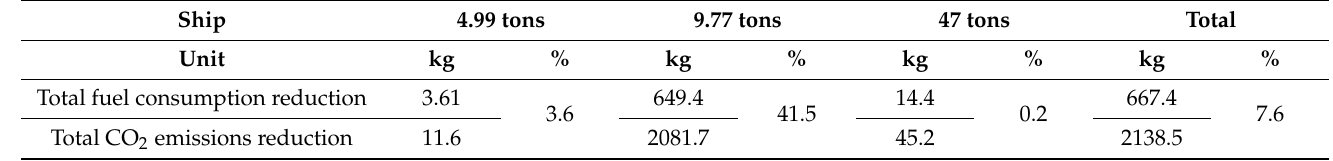
Table 3. CO 2 emission reduction in proposed battery hybrid fishing boats in idling and